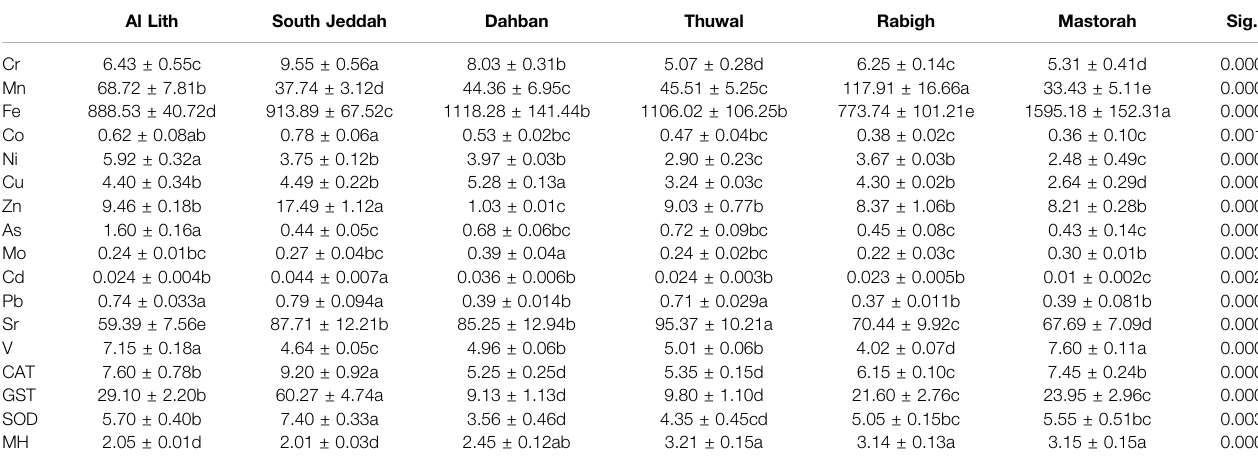
TABLE 3 | Heavy metal concentrations and antioxidant enzyme activities in mangrove A. marina . Al Lith South Jeddah Dahban Thuwal Rabigh Mastorah